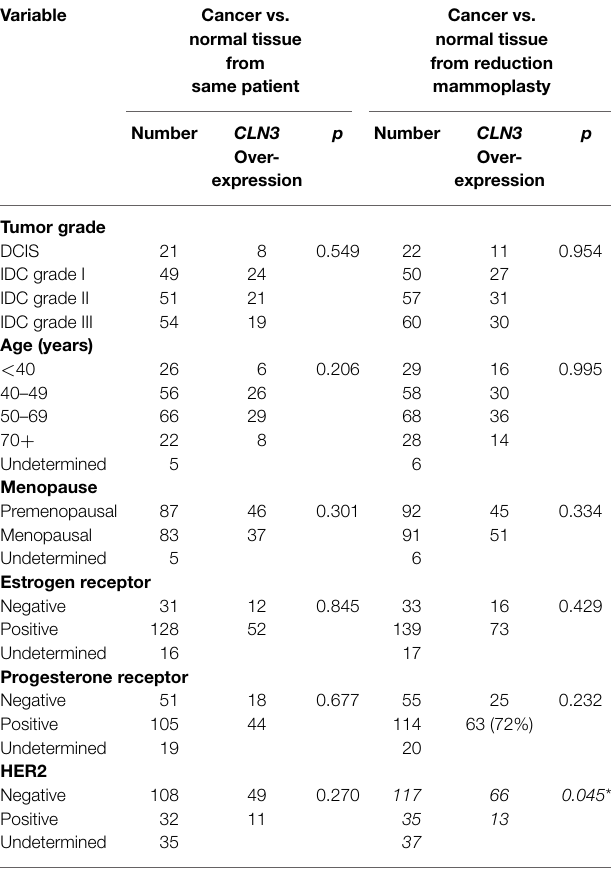
TABLE 1 | Relationship between CLN3 mRNA overexpression and patient clinicopathological parameters of the FFPE breast carcinoma tissue . Variable Cancer vs. Cancer vs. normal tissue normal from same patient